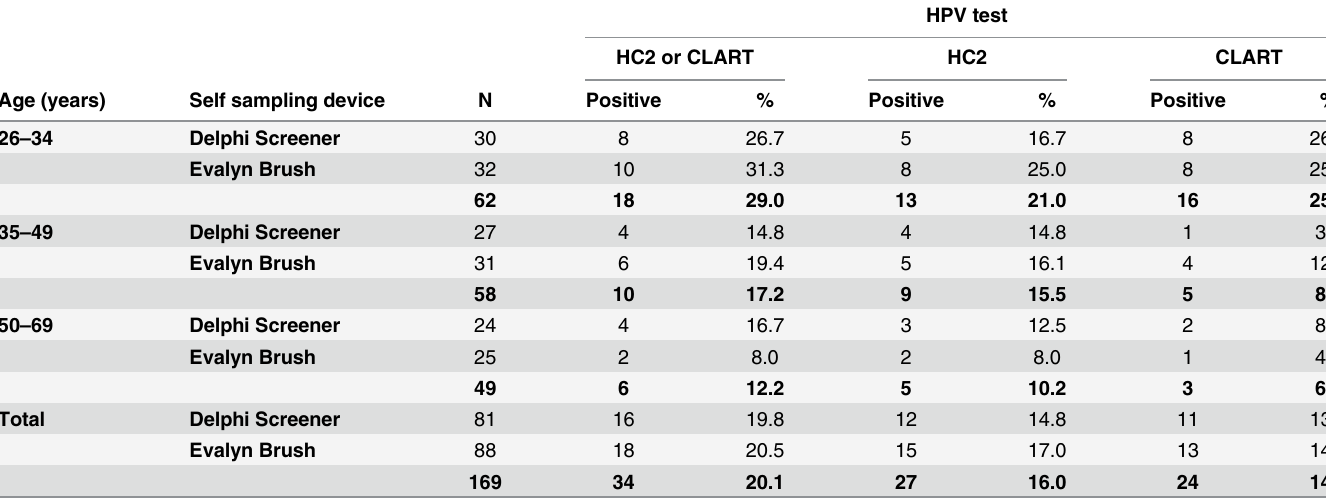
Table 2. High-risk human papillomavirus (hrHPV) positivity by age, HPV test, and self-sampling device.